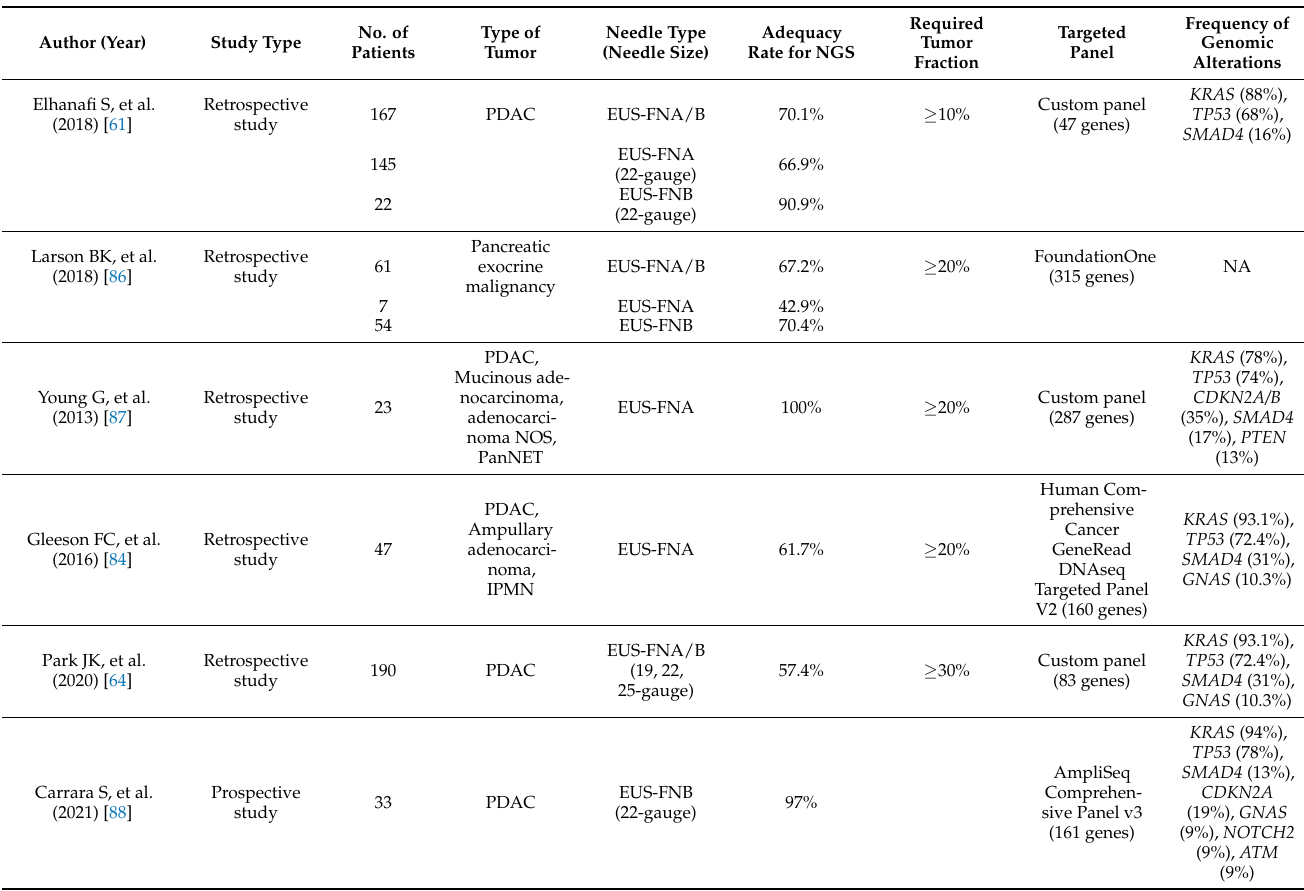
Table 1. Adequacy rate of EUS-TA samples for NGS (target genome sequencing) in pancreatic